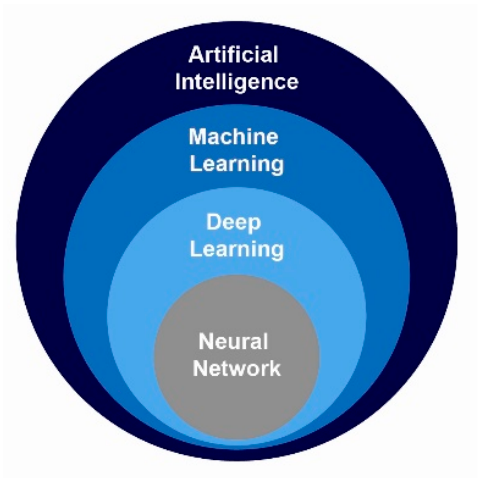
Figure 5. Deep learning is a type of machine learning. Expert systems can exceed human-level achievements in the diagnosis of a disease.